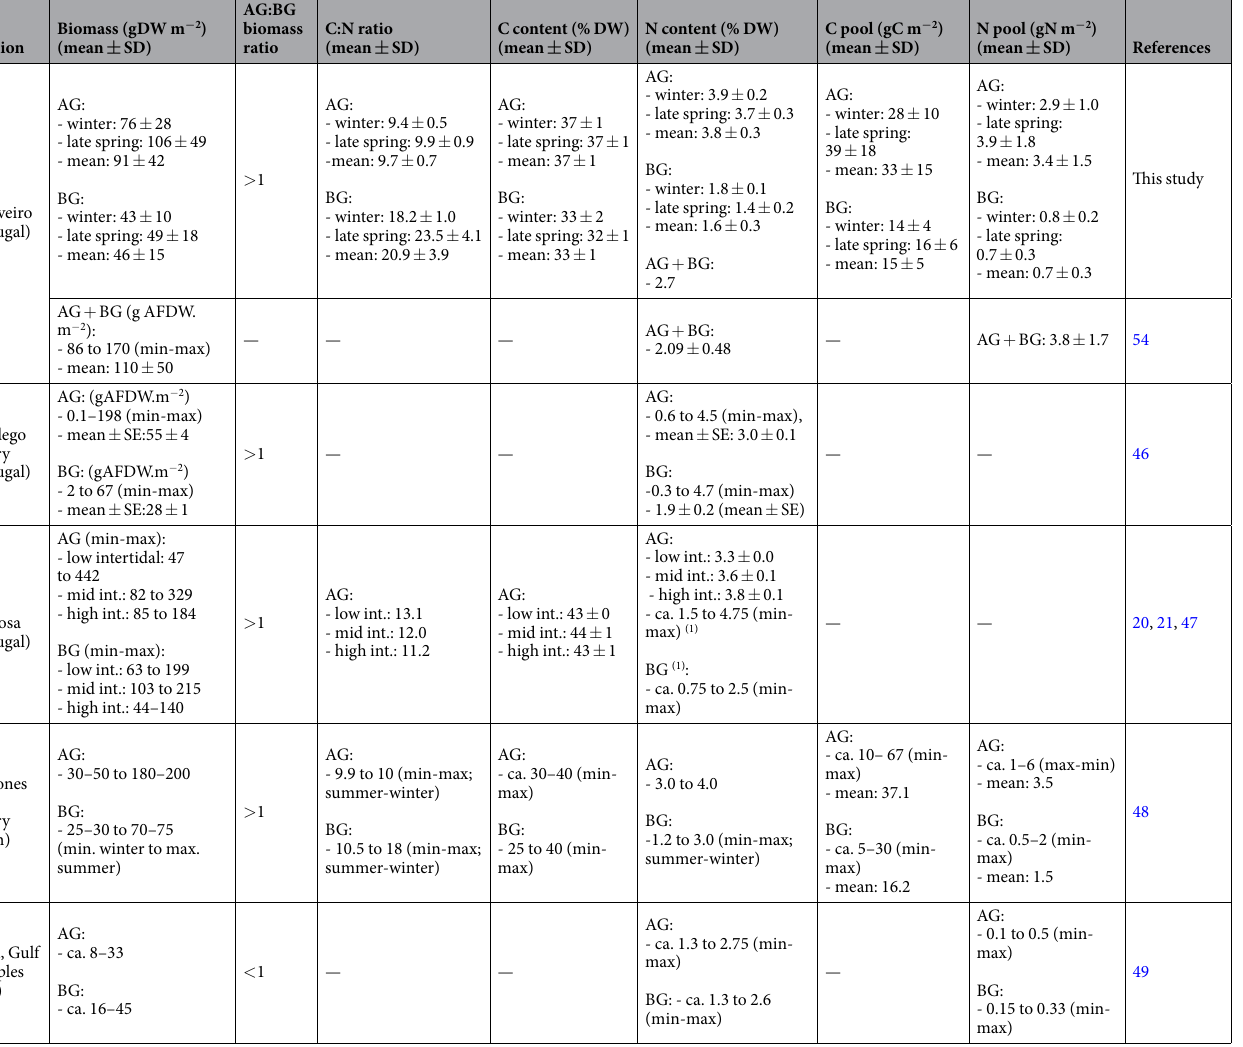
Table 2. Zostera noltei biomass, carbon (C) and nitrogen (N) dynamics at different geographical locations (AG – aboveground; BG – belowground; mean ± standard deviation; DW: dry